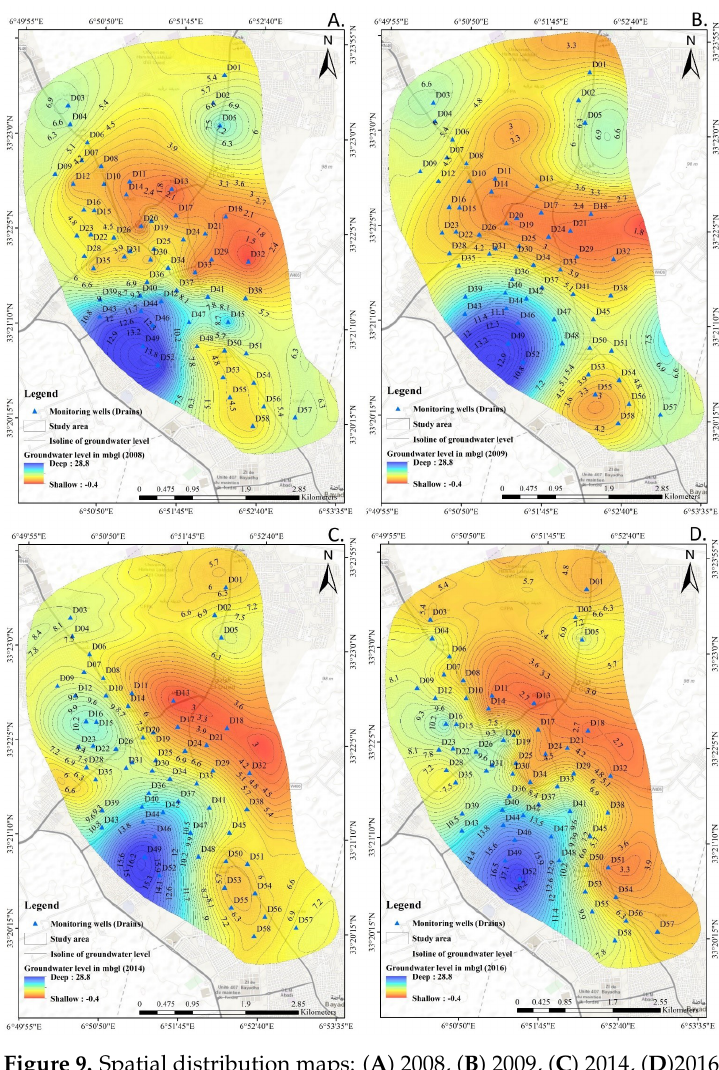
The groundwater level started its significant decline from 2014 and 2016, respec- tively. However, the shallowest groundwater levels were observed as usual in a gradual upwelling state from the central northwest part to the southeast of the study area to reach the minimum value that was marked in D13 with 0.6 mbgl in 2014 and 1 mbgl in 2016. The deepest levels were noted in the southwest of the study area, where the levels were more than 8 mbgl and increased deeply (significant decline) to 18.23 and 19.53 mbgl marked in D52 in 2014 and 2016, respectively, as is illustrated in Figure 9 (C) and (D). Fluctuation rates ranged from 7.97 mbgl in 2014 and 7.81 mbgl in 2016, Table3. Moreover, the minimum groundwater level in 2018 has shifted to D32 with 5.1 mbgl and is located in the southeast part of the city, while the deepest also has shifted to D37 with 28.8 mbgl situated in the south of El Oued city. Meanwhile, the fluctuation rate in 2018 was 12.74 mbgl. Nevertheless, between 2008 and other years the difference in groundwater decline and rising rates are predicted to be − 0.36 m in 2009, 2.56 m in 2014, 2.39 m in 2016, and Figure 9. Spatial distribution maps: ( A ) 2008, ( B ) 2009, ( C ) 2014, ( D )2016. 7.32 m in 2018 as is shown in Figures 10 and 11E.